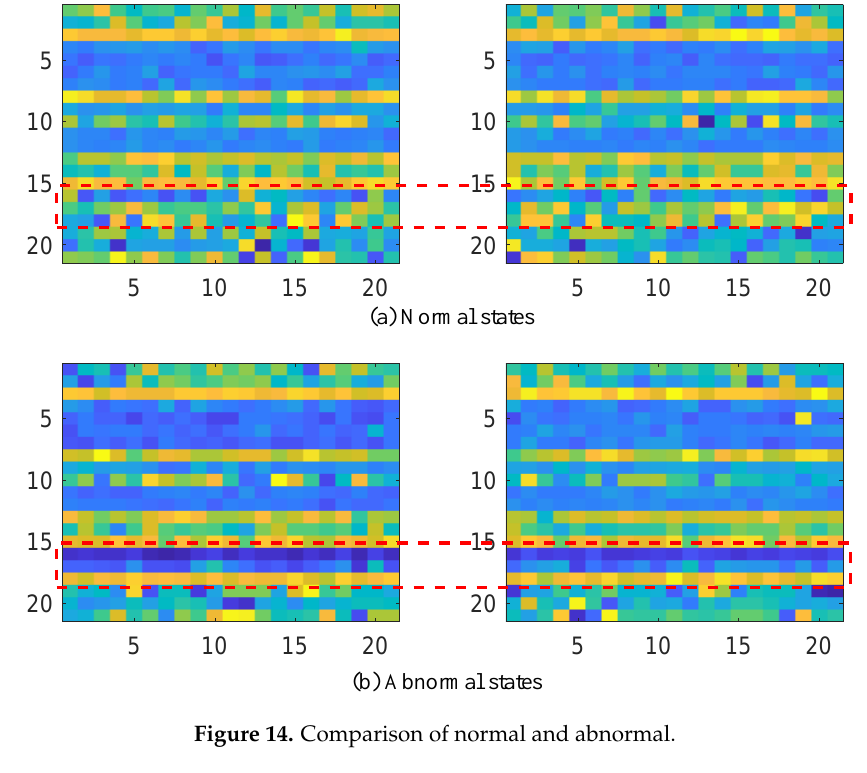
Figure 14. Comparison of normal and abnormal.